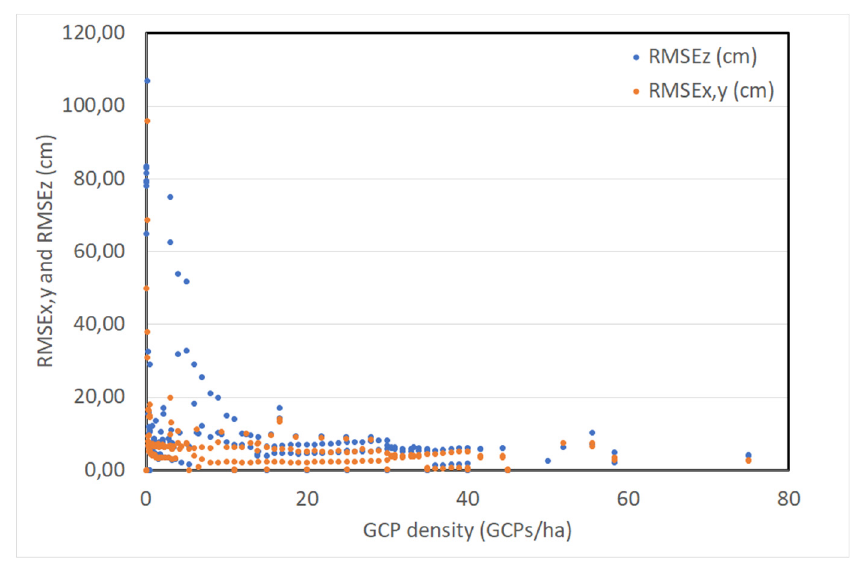
Figure 3. Planar root mean square error (RMSE xy ) and vertical root mean square error (RMSE z ) from a literature review, based on the work by [8,73,88–92].